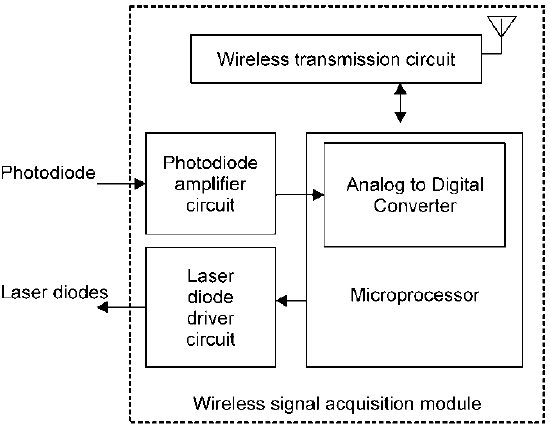
Figure 2. Block diagram of the wireless optical signal acquisition module.